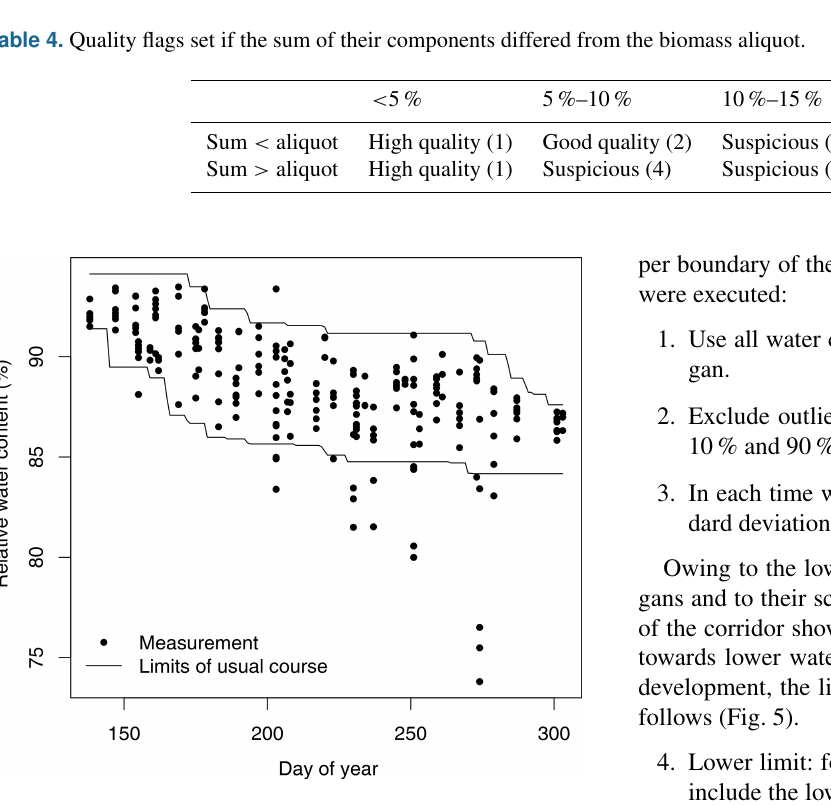
Figure 5. Temporal course of sugar beet leaves’ relative water con- tent (percentage of fresh weight, all available data). Black lines show the upper and lower limit of the “usual course” (definition in the text). Circles outside the limits of the usual course are assigned the unusual water content flag (3). These data may still be valid be- cause of heterogeneous conditions in a field (e.g., because of earlier